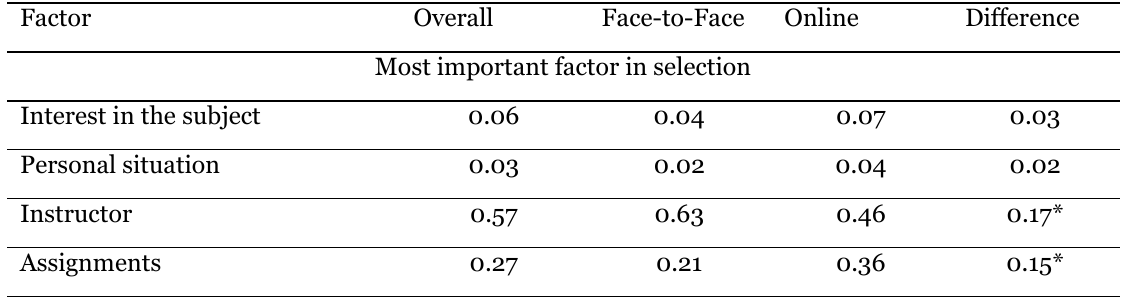
Difference of Means Tests Comparing Worst Face-to-Face and Online Classes: Main Factor Influencing Selection